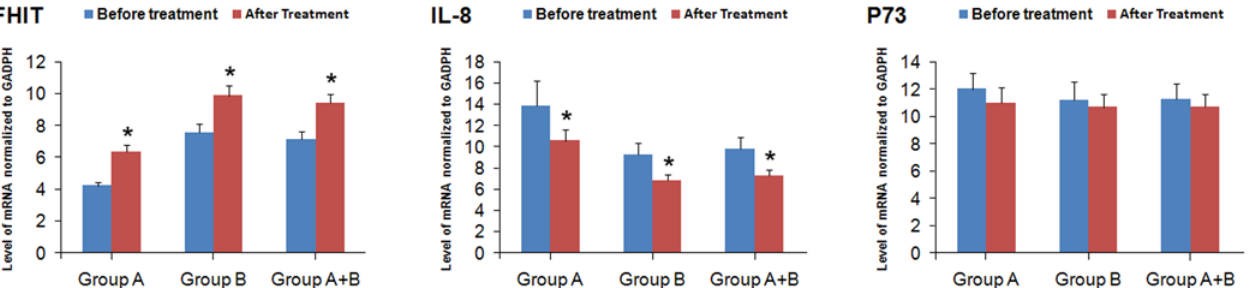
Fig 5. Effect of eradication of H . pylori on mRNA expression of FHIT, IL-8 and P73. A, patients with both H . pylori infection and family histories of gastric cancer. Group B, patients with H . Pylori infection and without family histories of gastric cancer. Data were expressed as the mean ± standard deviation. Statistical differences were determined by Wilcoxon rank-sum test. Compared with before treatment, * P < 0.05.